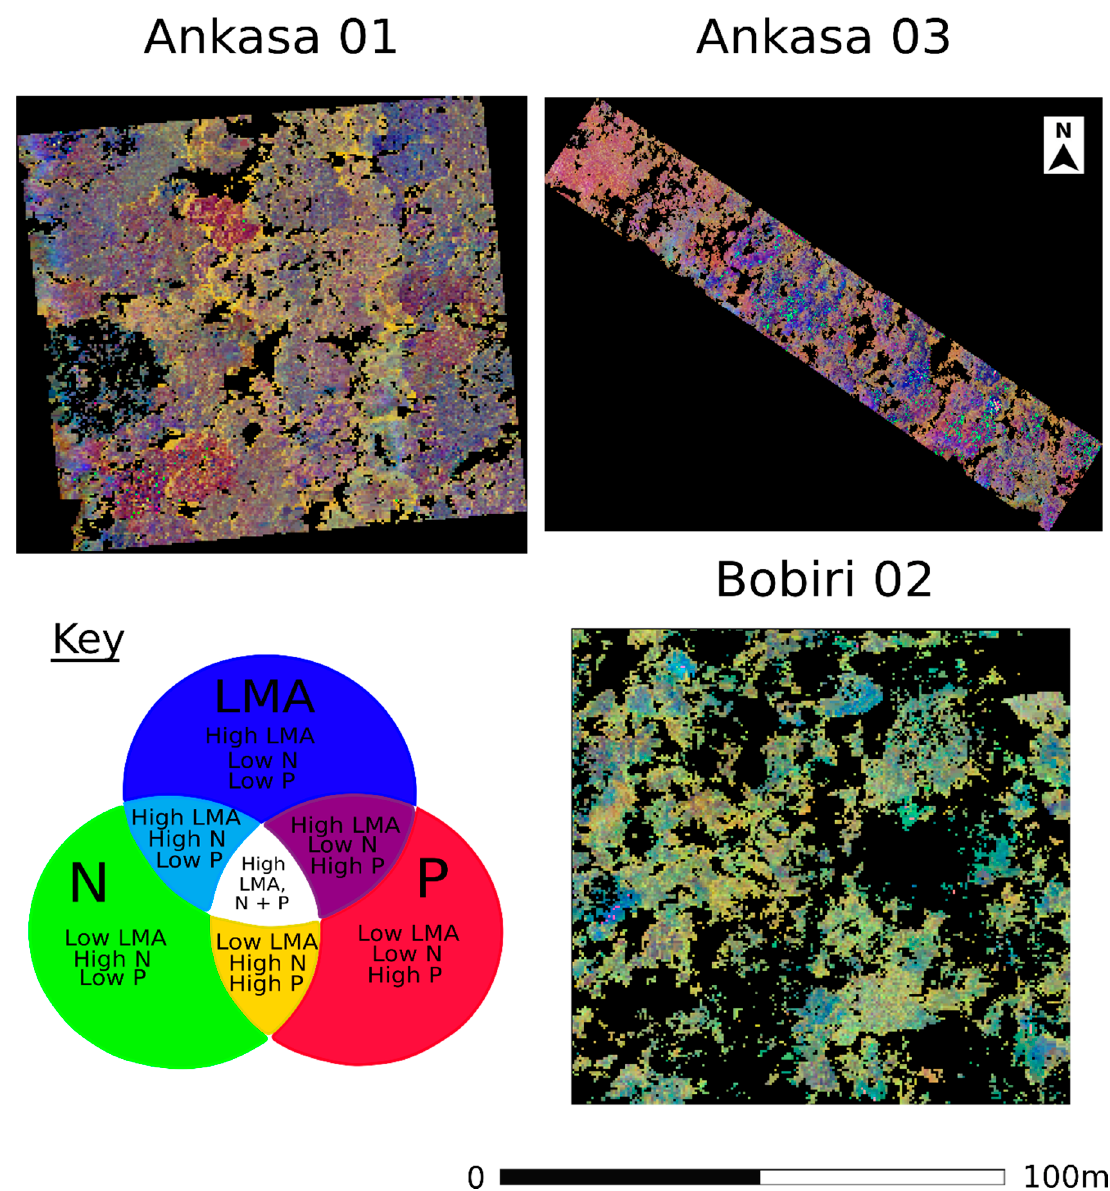
Figure 6. RGB composite of LES trait interactions (red = P, green = N, blue = LMA). Produced using the maps of predicted canopy LMA, N and P in Figure 4. Black areas represent shadows or areas with an NDVI < 0.6. In the Venn diagram, the continuous rgb colour scheme is shown as discrete categories for ease of interpretation. Pixel resolution = 0.5 m.